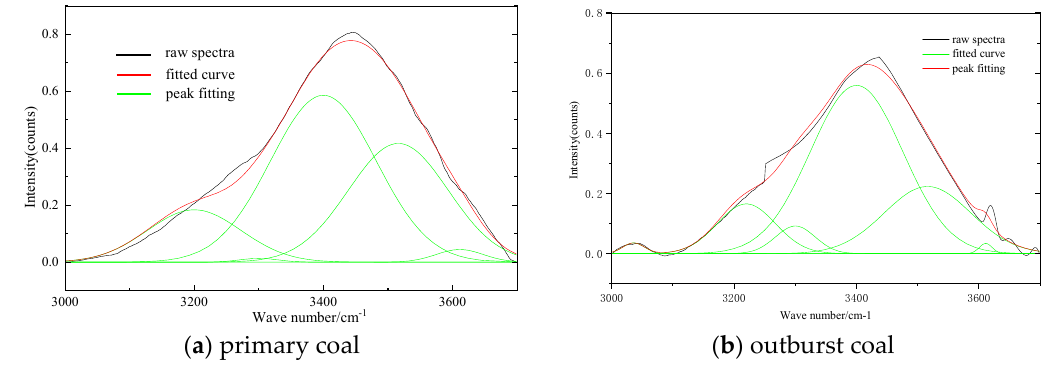
Figure 9. FTIR fitting spectra of hydroxyl structure.